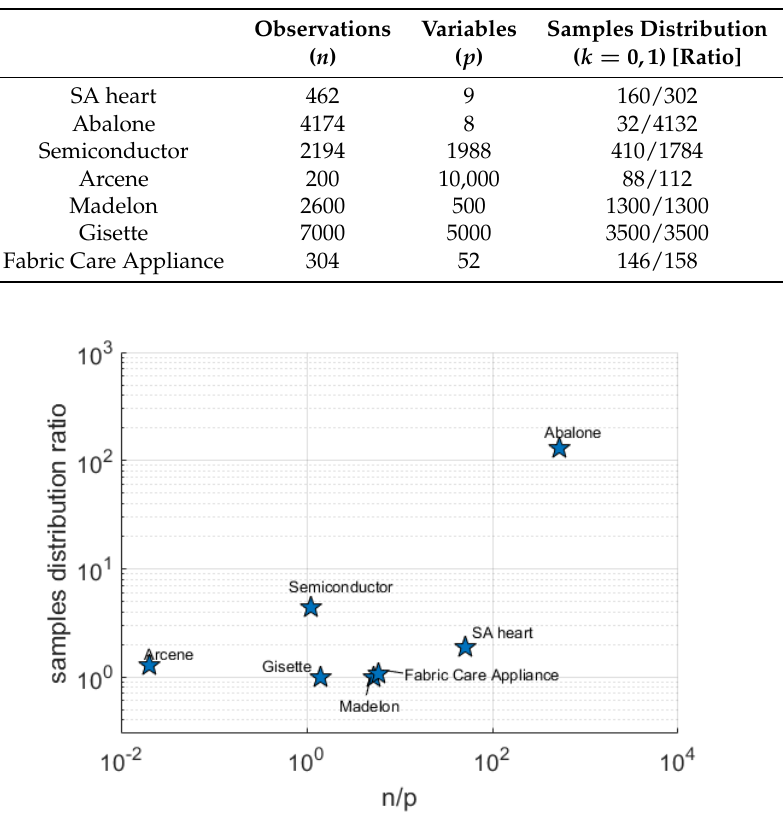
Figure 1. Diversity of real/artificial datasets in terms of class samples distribution and n